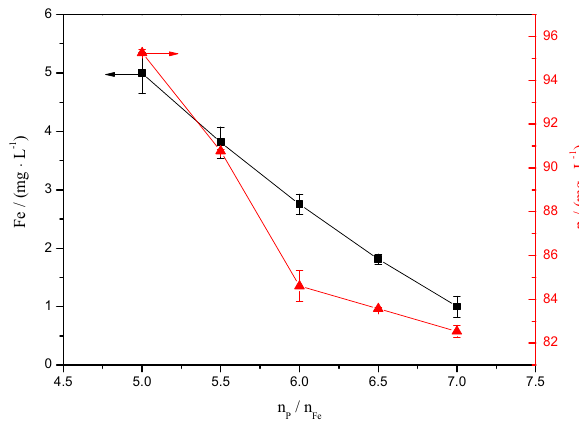
Figure 2: Content of iron and phosphorus in the fi ltrate at di ff erent phosphorus/iron molar ratios. T = 333 K, t = 60 min, pH = 2.0.